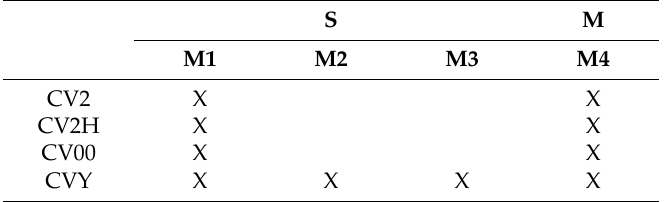
Table 1. Strategies (model-cv scheme) for predicting yield performance and associated traits (AT) for di ff erent approaches (S, single-trait; M multi-trait) and di ff erent training / testing sizes (further details in Figure